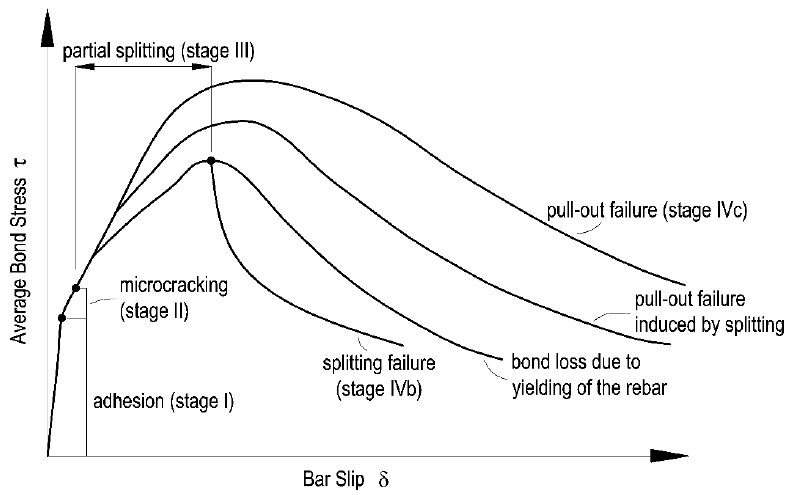
Figure 1. Typical local bond stress – slip relationship in different confinement conditions.